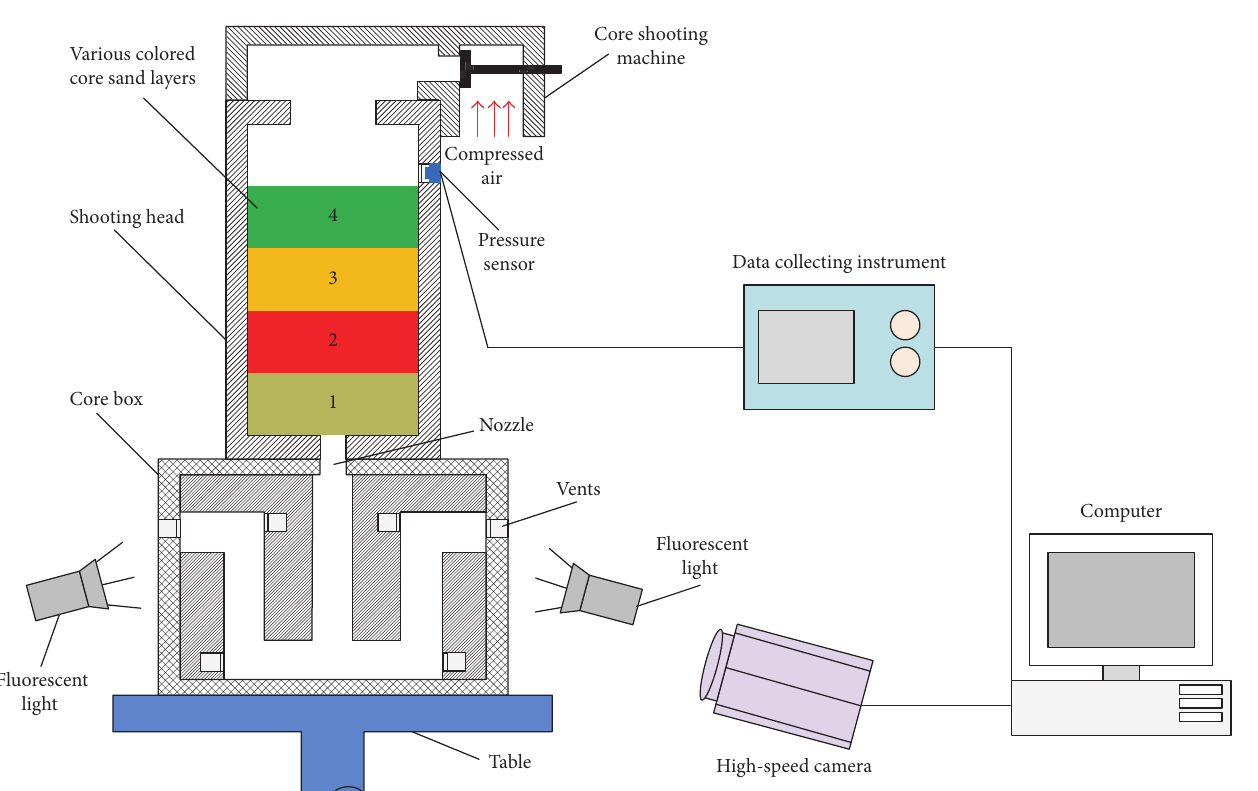
Figure 1: Schematic of the experimental